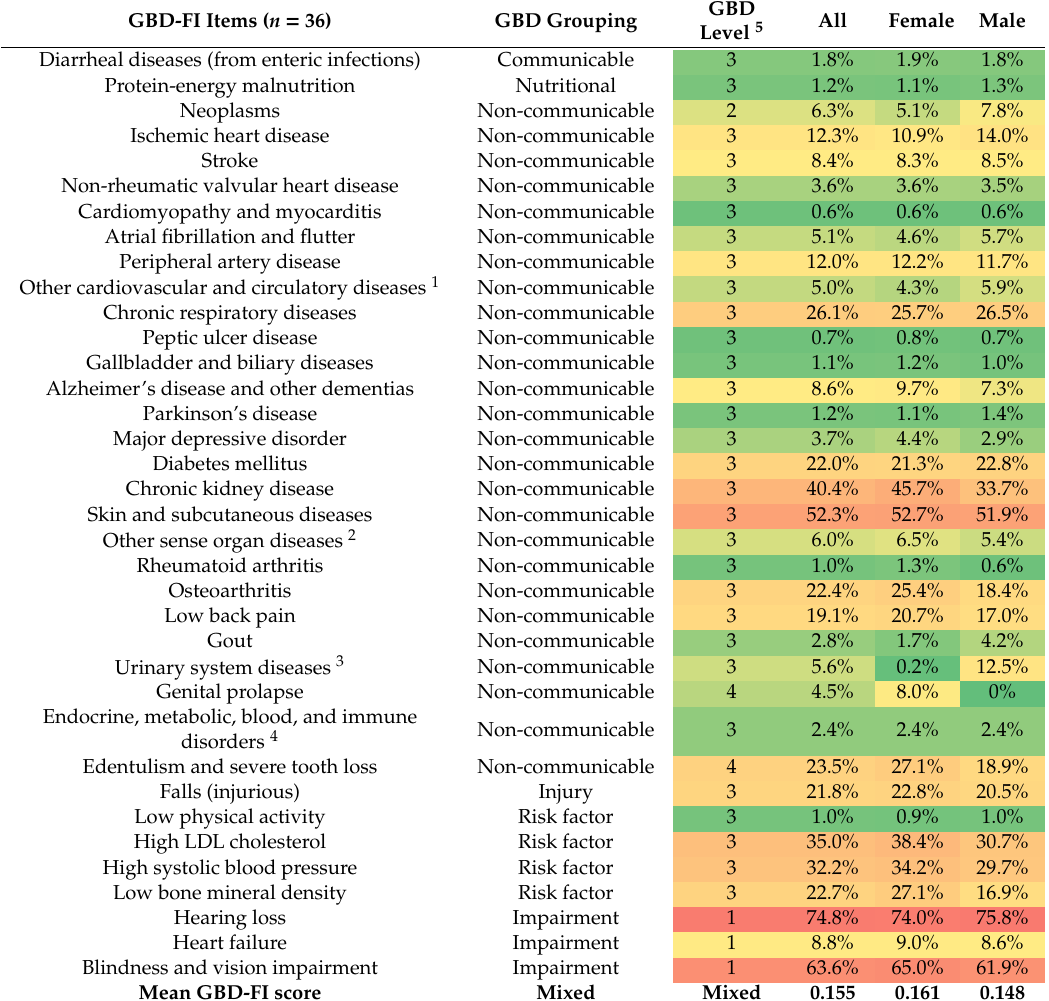
Table 1. Global prevalence (%) estimates of individual deficits ( n = 36) included in the GBD-FI for those aged ≥ 70 in 2017, globally and by